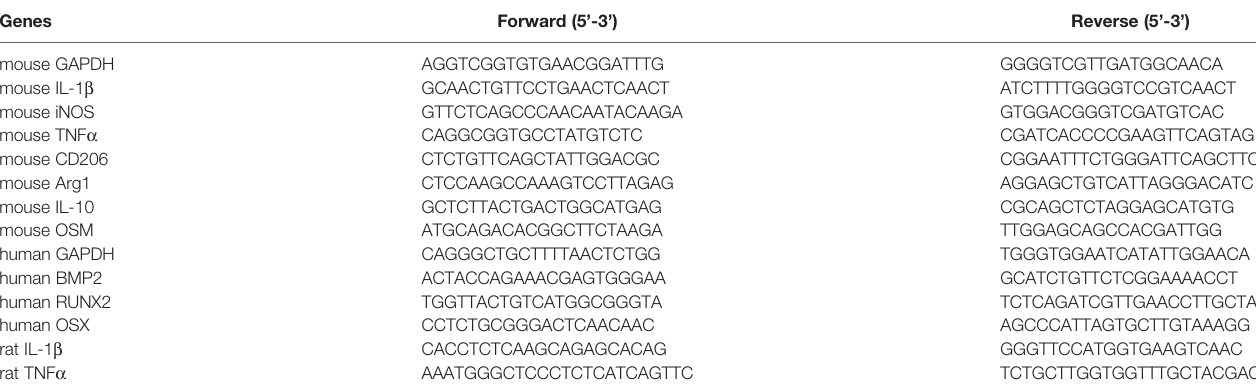
TABLE 1 | Primer pairs used for